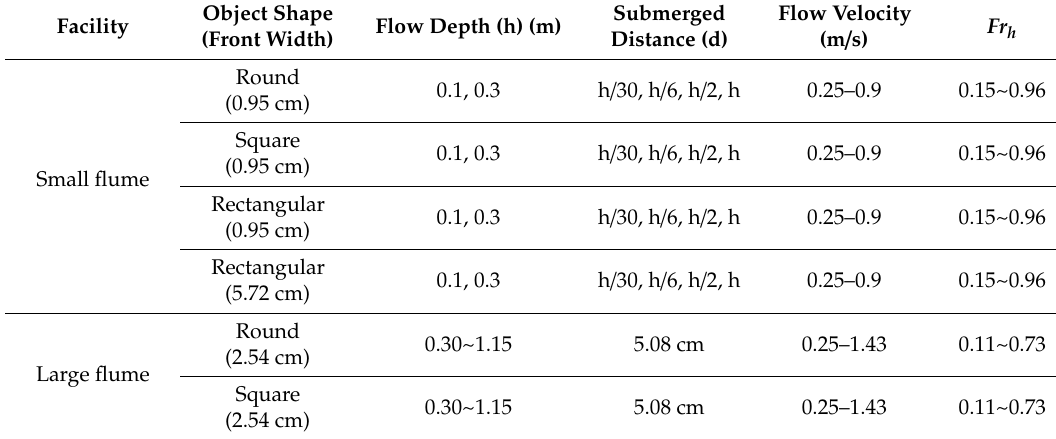
Table 1. Summary of experimental conditions.